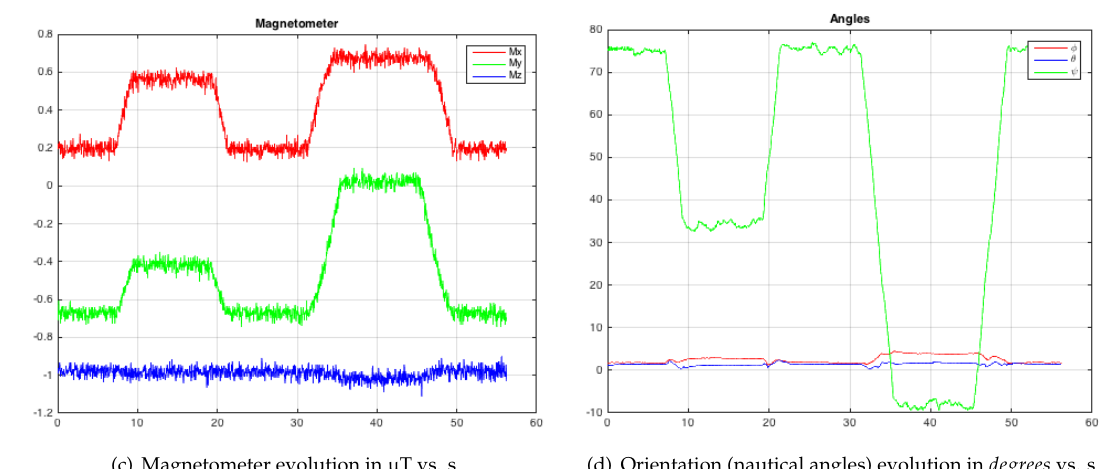
Figure 5. Test 1—Modifying the yaw angle ( ψ turn): data collected with the IMU and the orientation